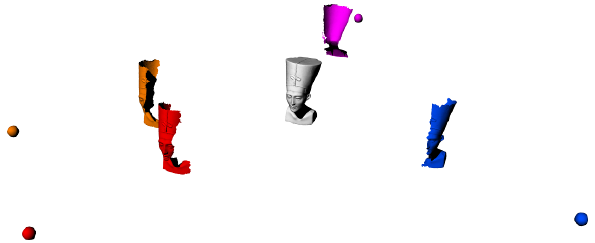
Figure 9. Outcome of the algorithm for a level of completeness of at least 90% with consideration of sufficient overlap